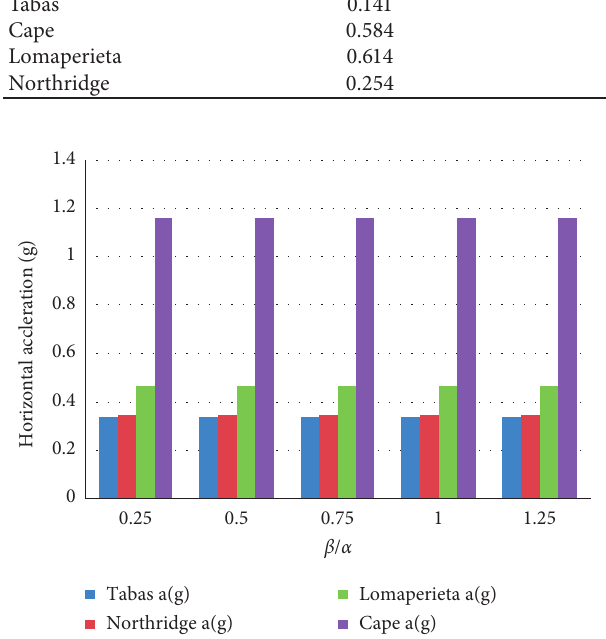
Figure 12: Maximum horizontal acceleration of tunnel lining at load combination 11 to 15.